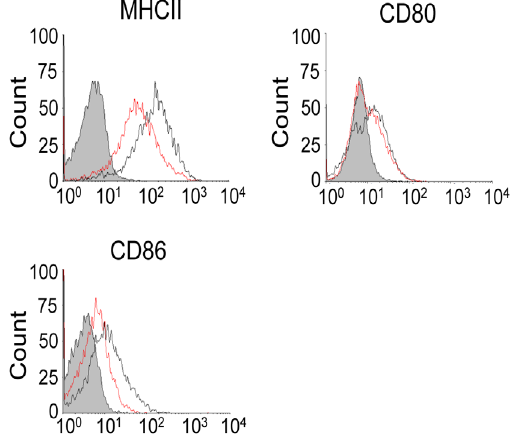
Figure 3. OmpA triggers expression of MHCII and CD86 on B cell. Splenic B cells were incubated without (red) or with (black) OmpA (5 m g/ml) for 24 h. Cells were harvested and assayed for cell surface expression of MHCII, CD80 and CD86. The shaded histograms indicate the isotype control antibodies. Representative data from three independent experiments are